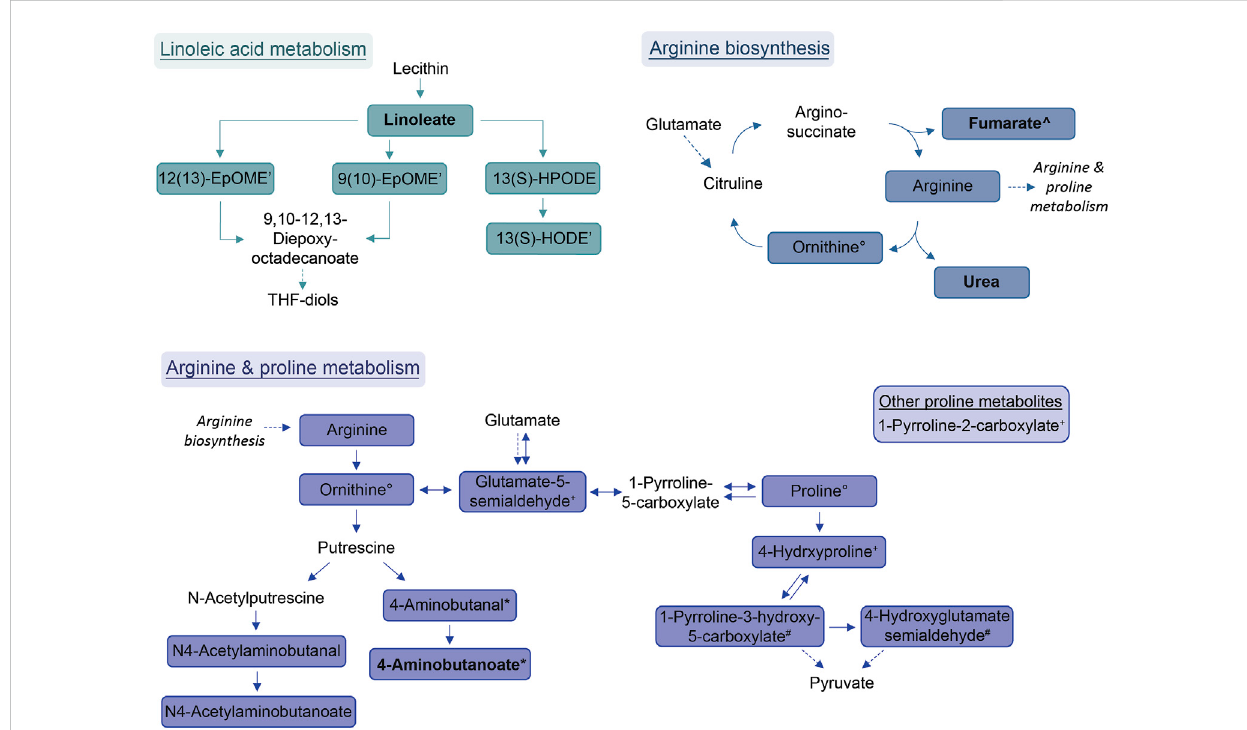
FIGURE 3 Schemesofmetabolicpathwayswell-representedbycompoundsthatweredecreasedintheallergicasthmagroupandputativelyidenti fi ed.Proline metabolism: One component is not directly connected to the displayed pathway and is shown in the box. Solid lines: direct metabolic relations; dashed lines: indirect metabolic relations; colored: putatively identi fi ed compound; bold: identi fi ed by MS 2 ; regular: identi fi ed based on exact mass and pathway mapping, or on literature; *, ° , + : several possibilities for 1 m/z feature based on exact mass and pathway